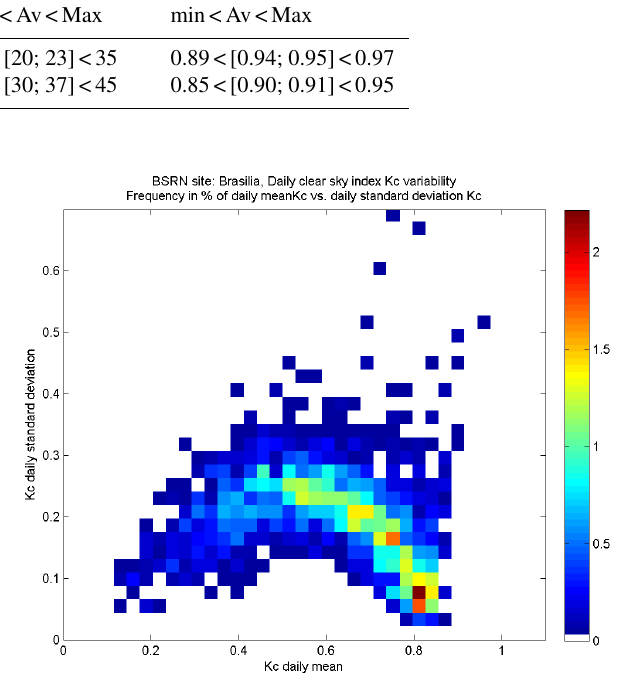
Figure 6. 2-D histogram of the daily mean of Kc on the horizontal axis and the daily standard deviation of Kc on the vertical axis for Brasilia. The frequency in percent is coded in colour with the scale given on the